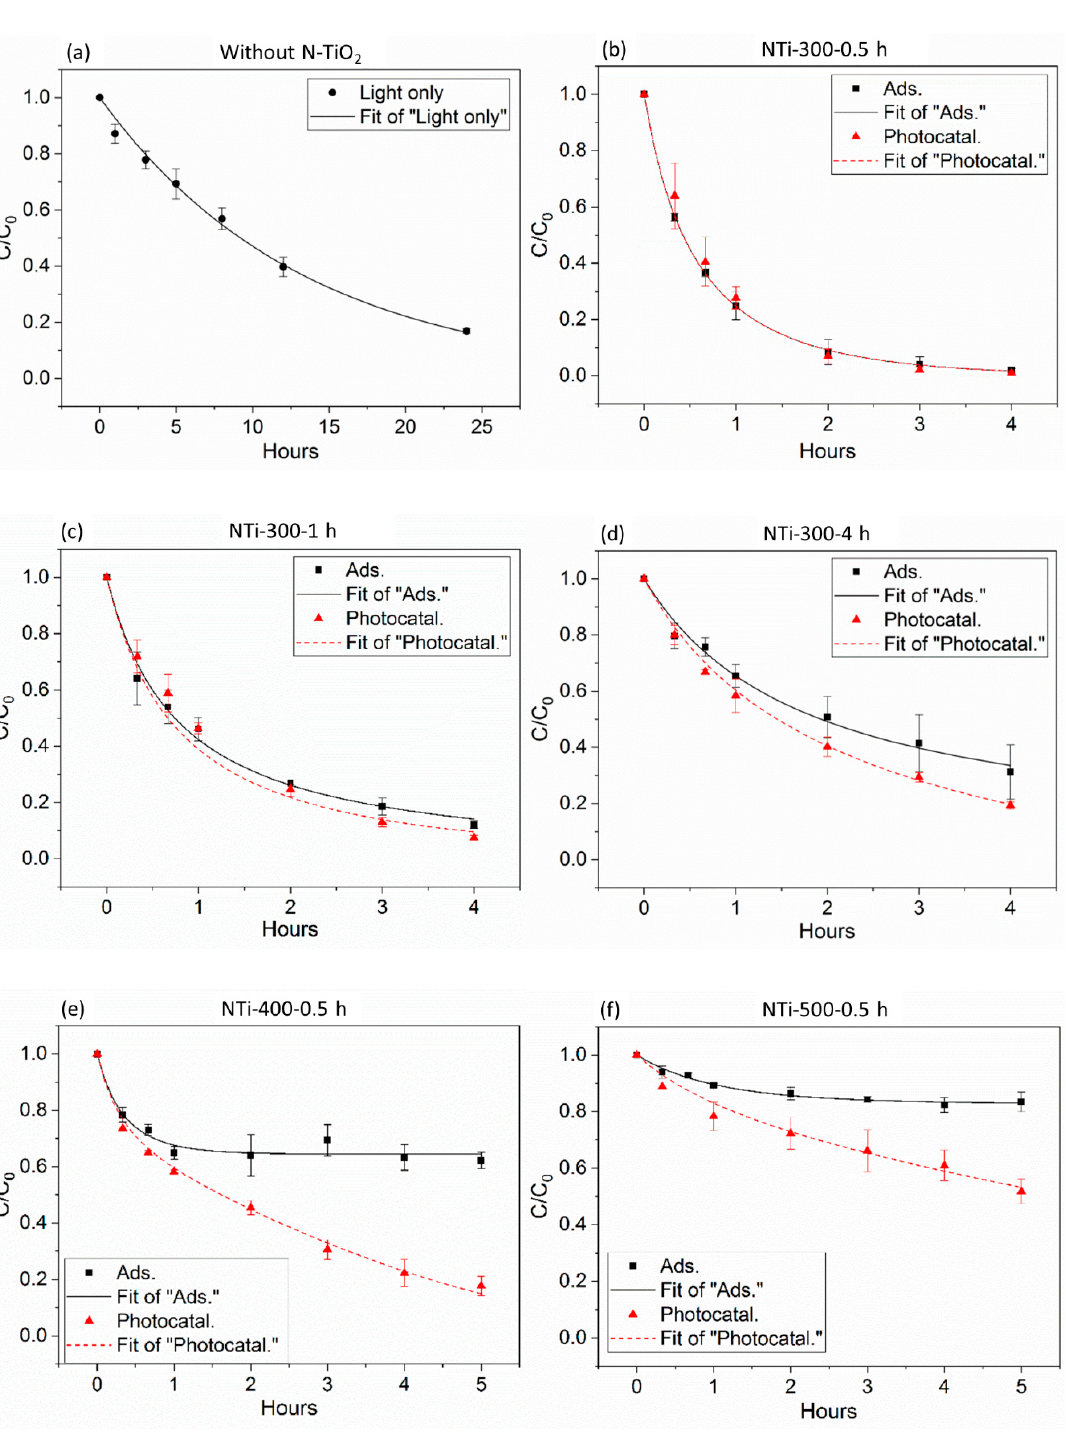
Figure 6. The adsorption and photocatalytic measurement of N-TiO 2 photocatalysts. ( a ) Methylene blue solution without N-TiO 2 irradiation by light, ( b ) NTi-300-0.5 h, ( c ) NTi-300-1 h, ( d ) NTi-300-4 h, ( e ) NTi-400-0.5 h, and ( f ) NTi-500-0.5 h.